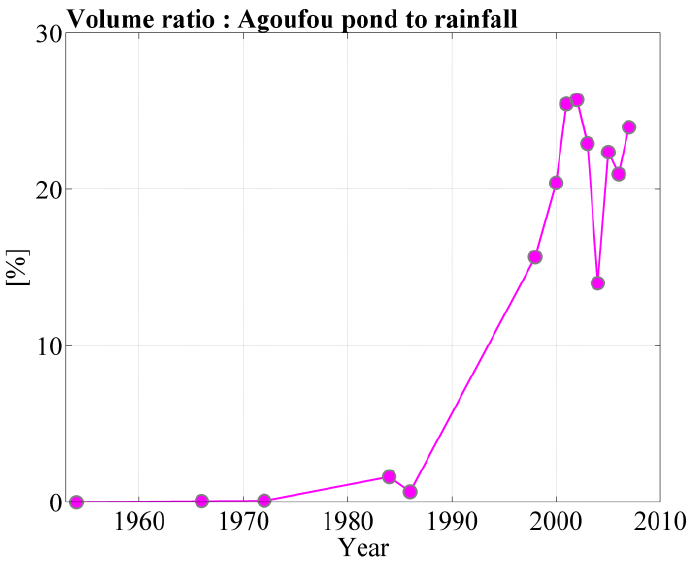
Figure 7. Time series of the ratio between the Agoufou pond’s annual volume increment and the annual rainfall collected over the catchment. The surface of the Agoufou pond is estimated from high spatial resolution remote sensing data while the height data come from field measurements. This ratio is a proxy for the run-off coefficient of the pond’s catchment. It has dramatically increased after the extreme droughts (early 1970s and early